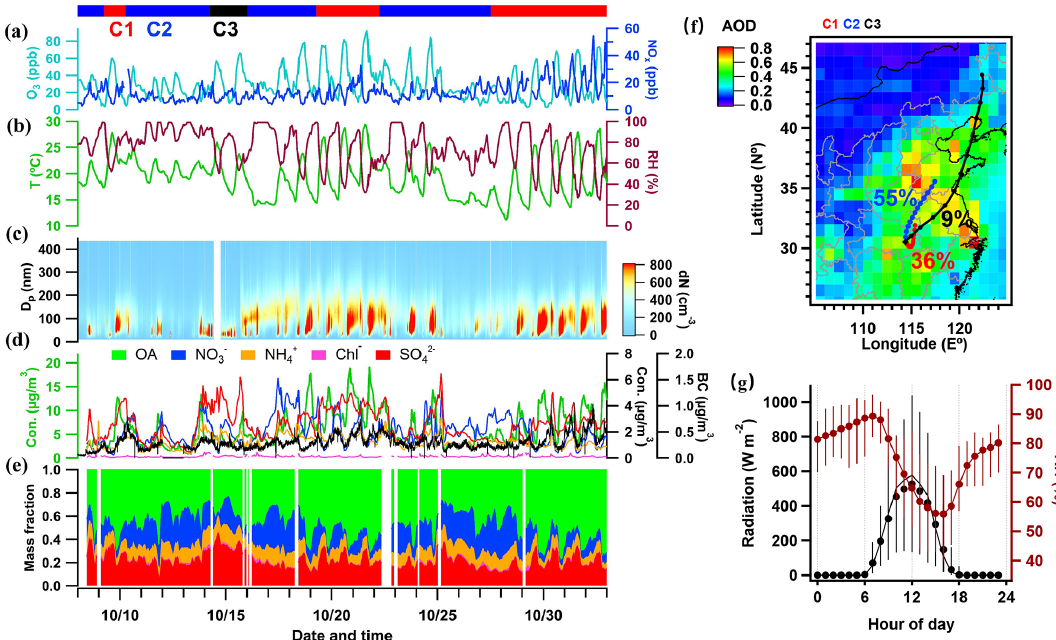
Figure 1. Time series of (a) mass concentrations of O 3 and NO x , (b) ambient temperature ( T ) and relative humidity (RH), and (c) the number size distribution measured by the SMPS. (d) Mass concentrations of key aerosol species (the green left y axis represents OA, and the right y axis represents other aerosol species). (e) Mass fractions of chemical species in non-refractory PM 1 . (f) Spatial distribution of mean aerosol optical depth (AOD) during the experiment and the clustered 36h backward trajectories. (g) Diurnal profiles of direct solar radiation and RH.